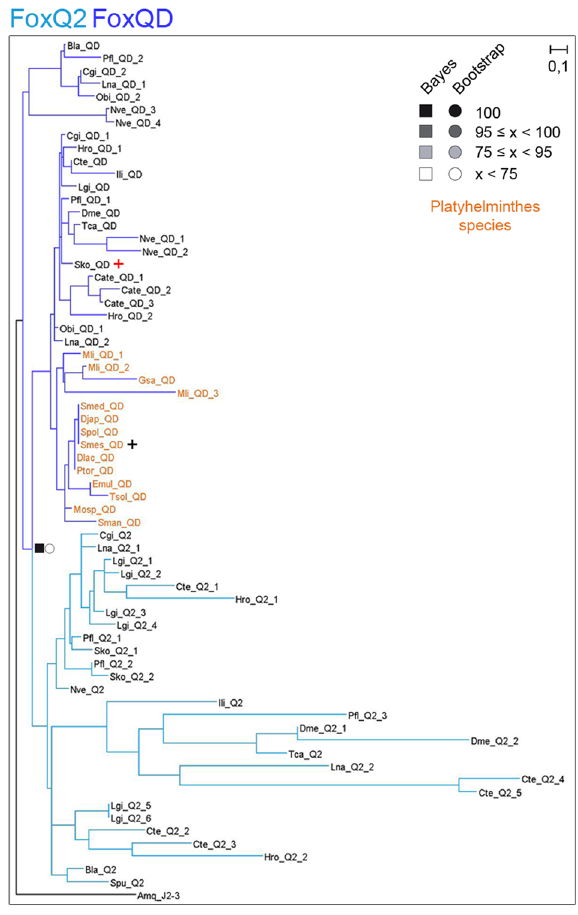
Figure 5. New family FoxQD is broadly found in Metazoa but missing in Vertebrata and Porifera. The ML phylogenetic trees based on FKH of Q2 and QD family evolution in all metazoan species studied in this work. At nodes, values for the approximate Bayes (square) and Likelihood (circle) ratio test are shown. Colour indicates % of confidence. An Amq-J2/3 from the opposite clade was used as out group. Family branches are painted with the same colour as they are represented in the trees. Dark asterisk indicates a new fox characterized in Schmidtea mediterranea ( Smed ). Red cross indicates Saccoglossus kowalewski foxQD gene. Platyhelminthes QD genes are coloured light orange. Aminoacidic sequences used are placed in S1 and S3 File. Scale indicates expected aminoacidic substitution per